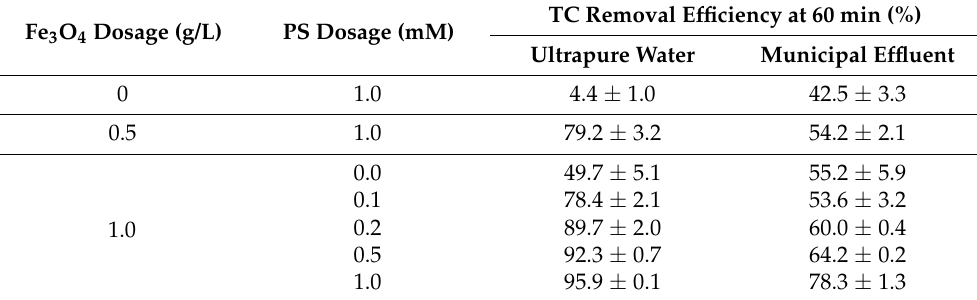
Table 2. TC removal efficiencies in ultrapure water and municipal effluent according to various reaction